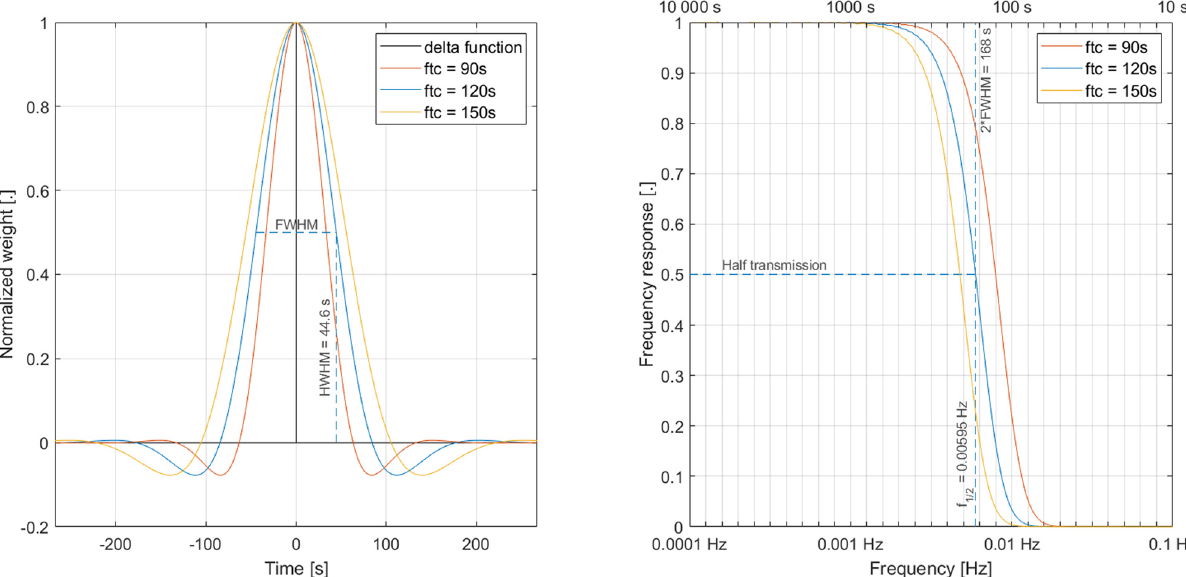
Figure 1: Illustration of third - stage, second - order Butterworth fi lter with three di ff erent time constants of 90, 120, and 150 s applied to a delta function. ( Left ) Normalized convolution fi lters. ( Right ) Transfer functions ( more speci fi cally frequency response functions ) . Note the units of frequency at the bottom and time at the